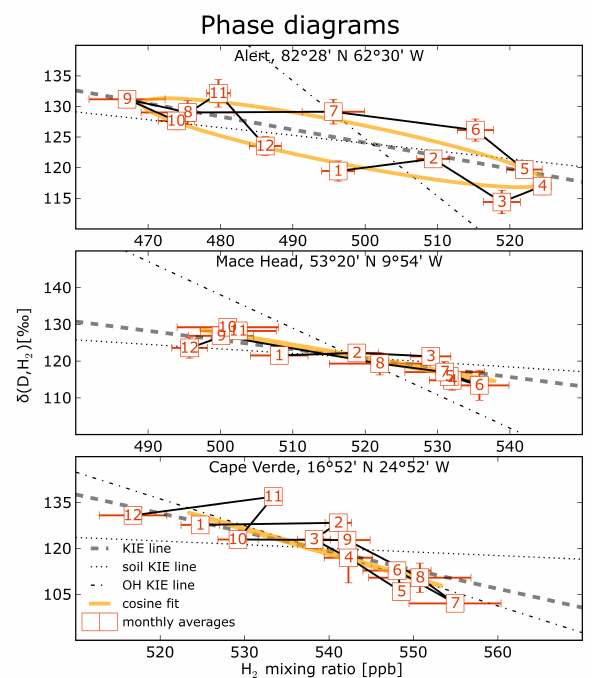
Fig. 6. Phase diagrams ( δ D vs. m (H 2 )) of the monthly averages (labelled with month number) of the three stations that show clear seasonal cycles. The orange ellipses are derived from the sinusoidal fits to the time series. The thick grey dashed line is the “KIE” line for the apparent fractionation factor determined from the fractiona- tion plot for the respective station as defined in (Allan et al., 2001). The dotted and dash-dotted lines are the KIE lines for the two dif- ferent sink processes, with values for α from (Rhee et al., 2006b). Note that the determined KIE line at Alert and Mace Head is closest to the soil uptake KIE line, while the determined KIE line at Cape Verde is closer to the OH oxidation KIE line.